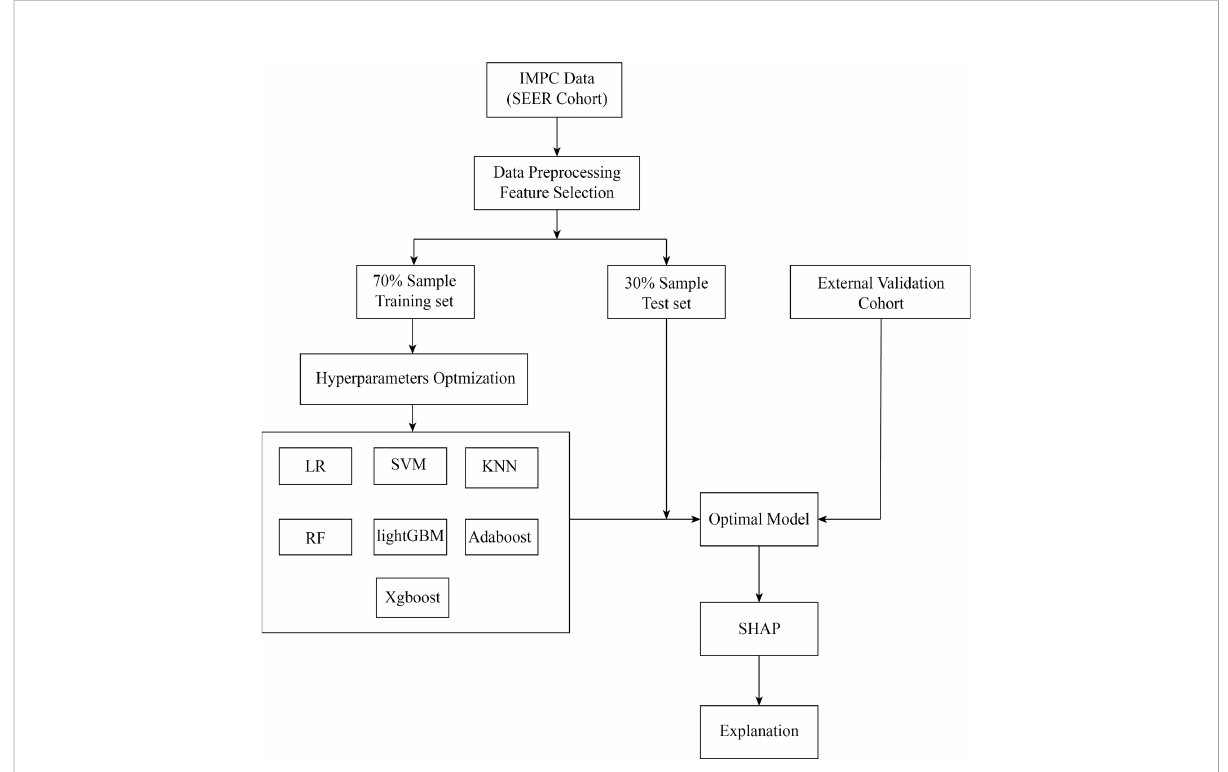
FIGURE 1 Flow chart for the development, explanation and validation of